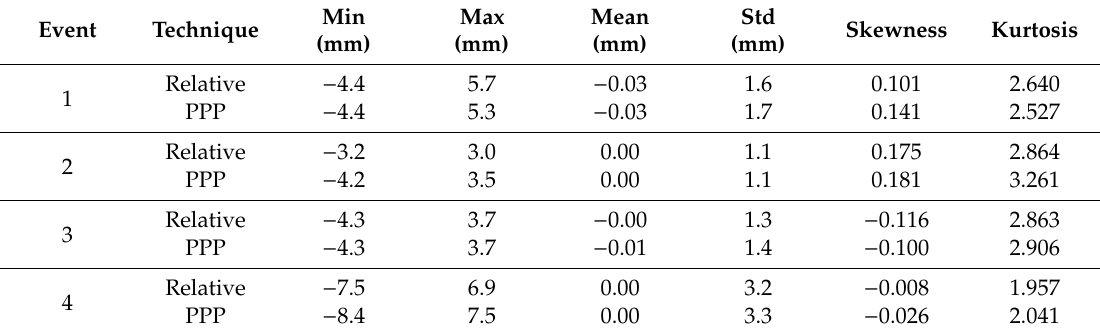
Table 3. Statistical results of GNSS